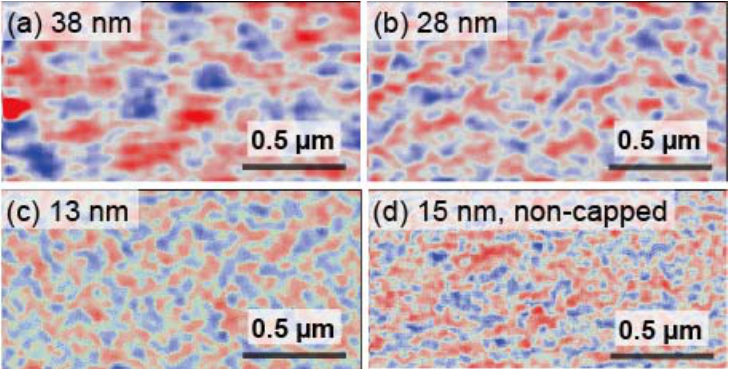
Figure 5. Magnetic images at 300 K for Ti 0.95 Co 0.05 O 2 −δ thin films with different film thicknesses ( a – c ) with a 2 ‐ nm ‐ thick capping layer and ( d ) without a capping layer.